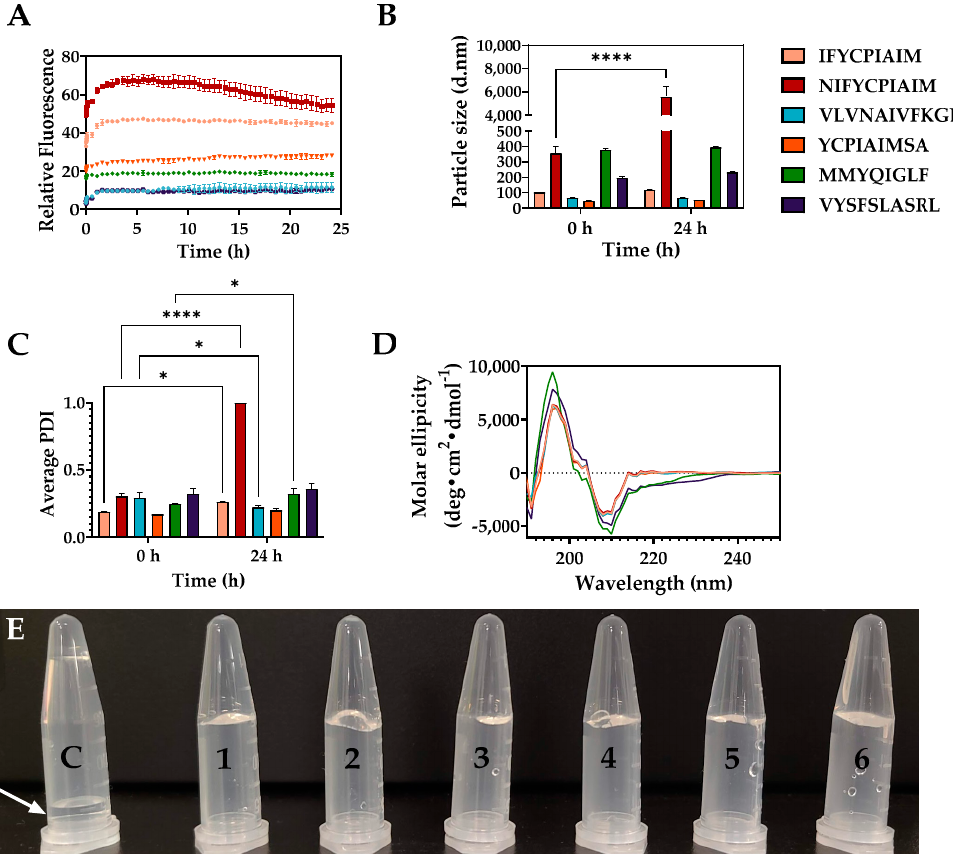
Figure 3. ( A ) Thioflavin T fluorescence kinetics, ( B ) particle diameter, ( C ) polydispersity index (PDI), and ( D ) circular dichroism spectra of the ovalbumin-derived peptides. ( E ) Formation of hydrogels that maintain their shape in test tubes. Control, “C“, indicates water mixed with the same concentration ( v / v ) of DMSO in water. * = significant (0.01 < p < 0.05), **** = extremely significant (p < 0.0001).